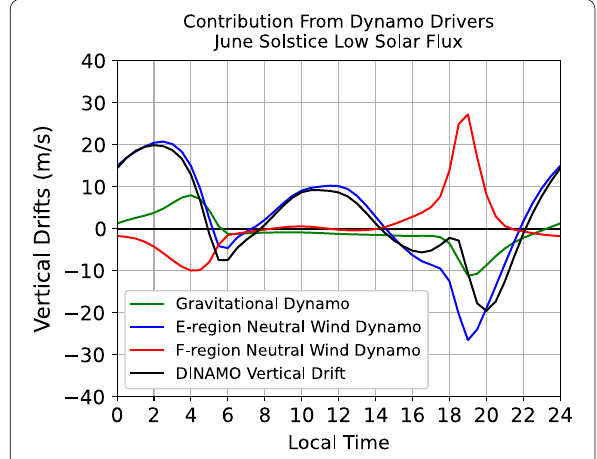
Fig. 4 Jicamarca vertical drifts (black line) due to the gravitation dynamo (green line), the E -region dynamo (blue line), and the F -region dynamo (red